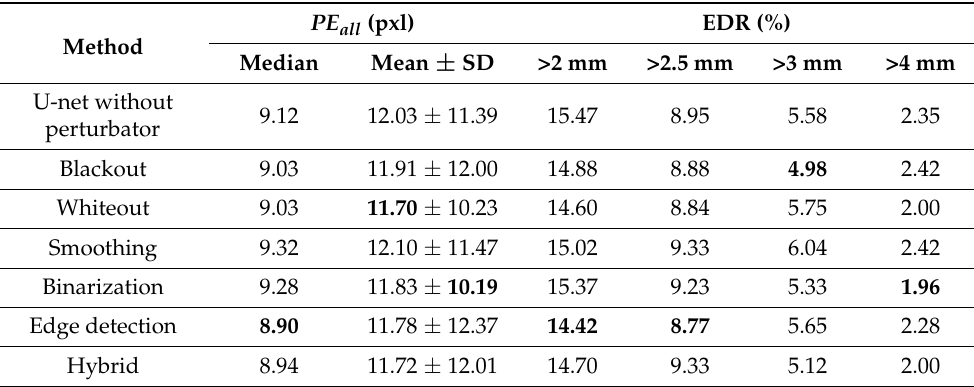
Table 4. Localization results according to perturbator on the ISBI 2015 dataset (test1).